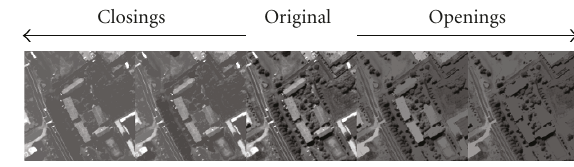
Figure 1: Simple morphological profile with 2 openings and 2 closings. In the profile shown, circular structuring elements are used with radius increment 4 ( r = 4, 8 pixels). The image processed is part of Figure 4(a).